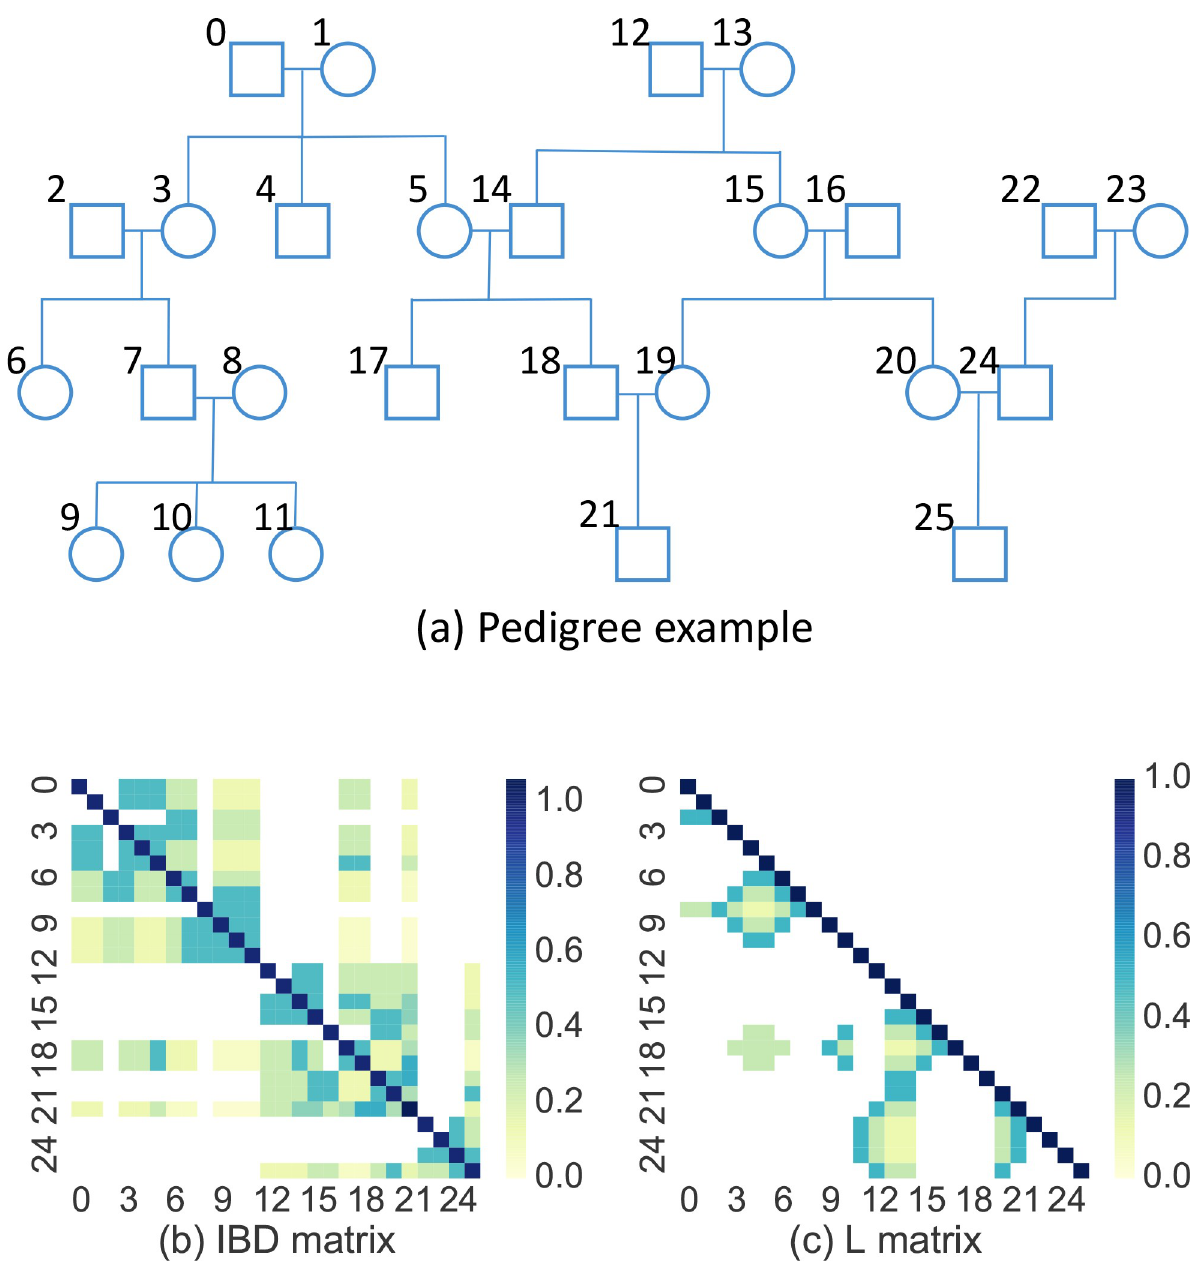
Fig 1. A demonstration of the Sci-LMM IBD matrix construction algorithm. ( a ) An example pedigree with 26 individuals. ( b ) A heat-map representing the IBD matrix, where zero elements are white to emphasize sparsity. ( c ) A heat-map representing the lower Cholesky factorization of the IBD matrix (i.e. the matrix L in the factorization A = LHL T , where A is the IBD matrix). The value of entry i , j is the expected fraction of the genome that is shared between individual i and her ancestor j .